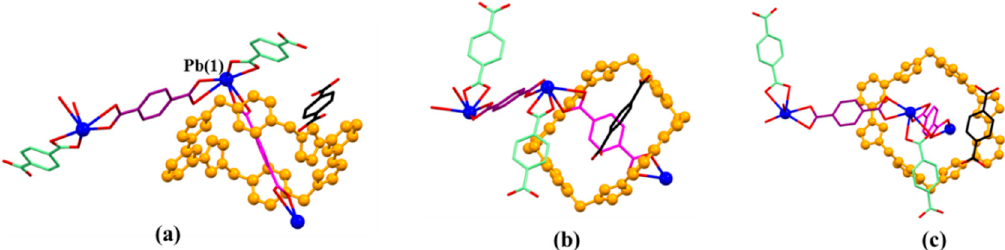
Figure 4. Top ( a ), side ( b ), and front ( c ) views of the monomer unit of MORF-Pb-1 formed from 1 4+ , 2 , 2H + • 2 , and Pb 2+ . Note: Different colours are used for the linkage anions to illustrate the different local chemical environments. Solvent molecules and the protons have been omitted for clarity; none of these components are involved in the framework structure. Monomer units can further construct a chain-shaped 1D polyrotaxane structure that extends infinitely in the direction of the crystallographic a -axis through the complexation between Pb(1) and 2 (highlighted with dark magenta colour) (Figure 5).